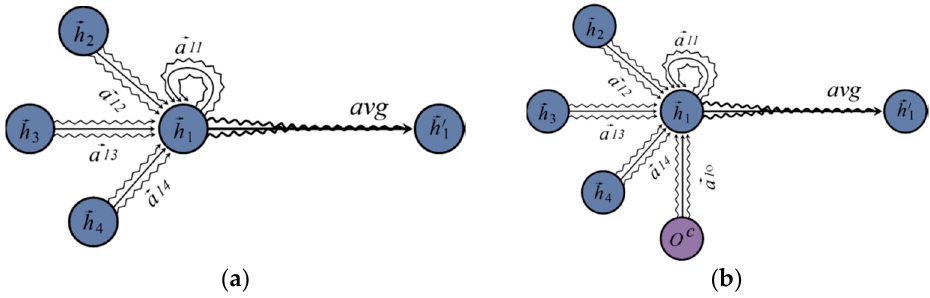
Figure 4. ( a ) An original graph attention unit; ( b ) an SRC-based graph attention unit. The purple circle labelled 𝑜 (cid:3030) represents the SRC features.